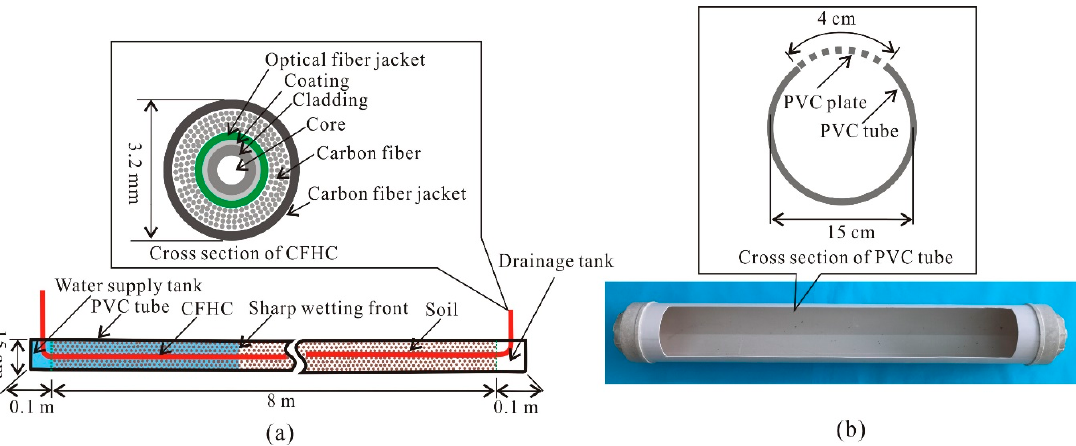
Figure 4. Configuration of the experimental apparatus: ( a ) soil column and cross section of the carbon fiber heated cable (CFHC); ( b ) cut region of the polyvinyl chloride (PVC) tube.